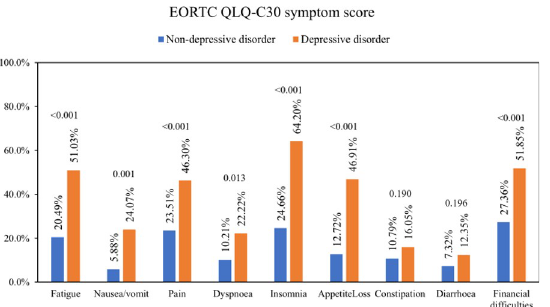
Fig 2. The means of EORTC QLQ-C30 symptoms scores of the depressed group compared to the non-depressed group, with p-values. A higher percentage on symptom scales indicates a poorer quality of life. Abbreviations: EORTC QLQ-C30, European Organisation for Research and Treatment of Cancer Quality of Life Core Questionnaire. P- values < 0.050 were considered statistically significant.